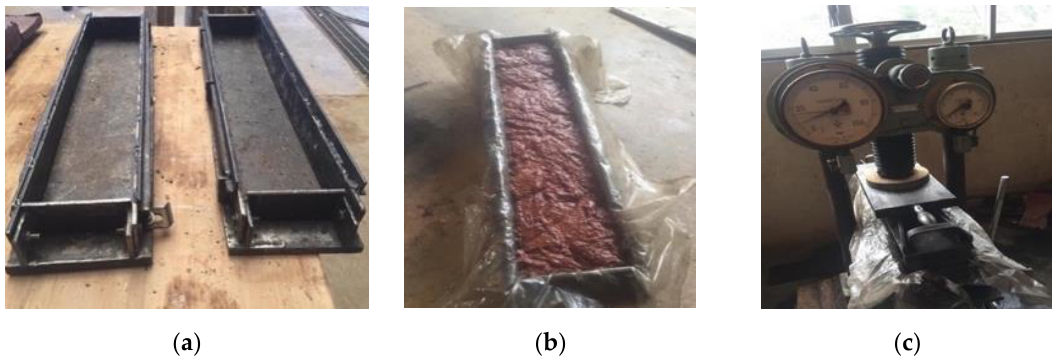
Figure 4. ( a ) Steel mold; ( b ) mixing in the mold; ( c ) compression of the sample under load.